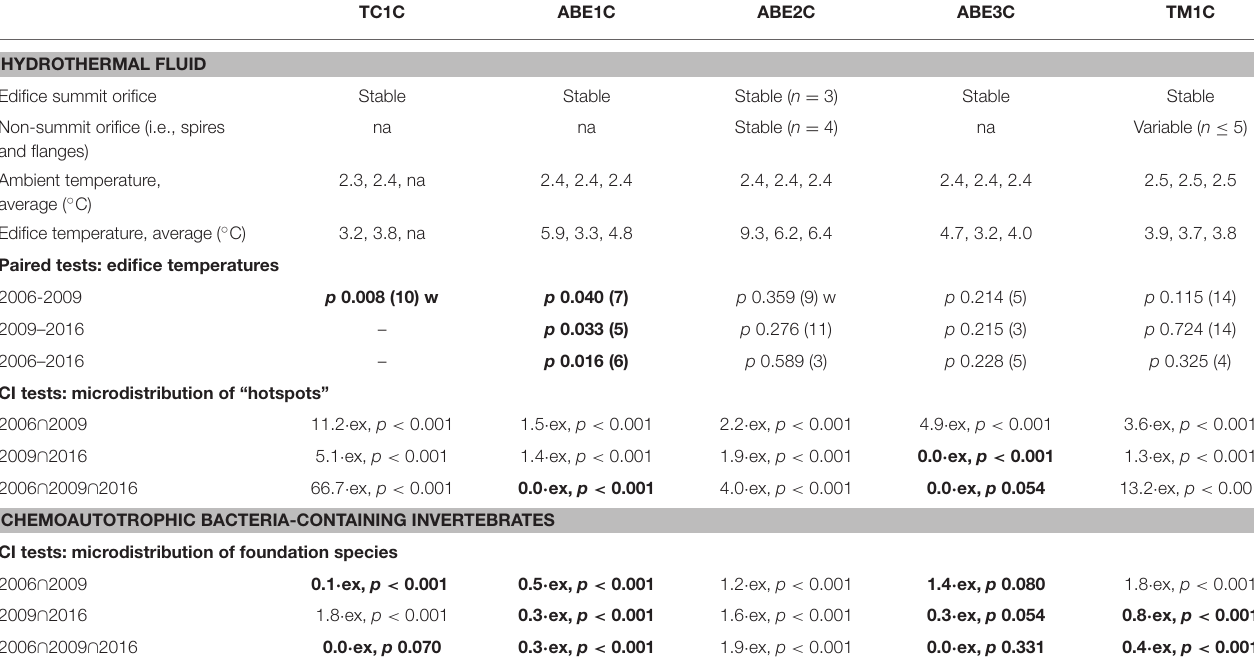
TABLE 2 | Spatio-temporal characteristics and analyses of the hydrothermal fluids and chemoautotrophic bacteria-containing invertebrates (foundation species) at the long-term study sites: Tow Cam (TC), ABE, and Tu’i Malila (TM) vent fields.